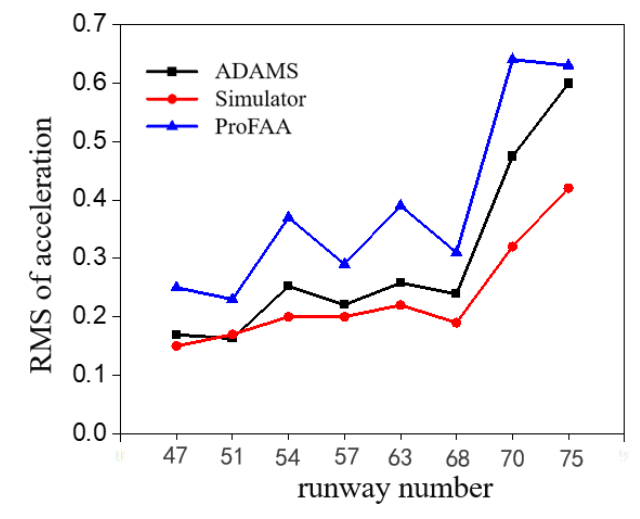
Figure 4. Comparison of results obtained from three different simulation methods.